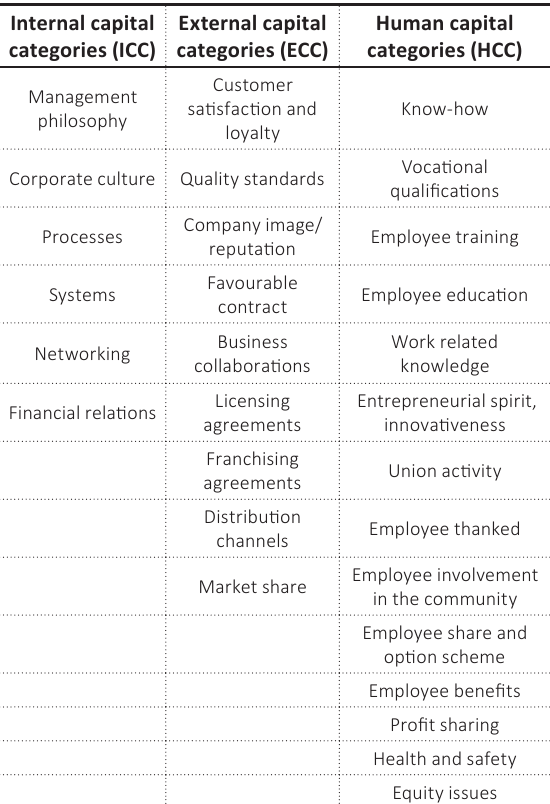
Table 2. Intellectual capital disclosure